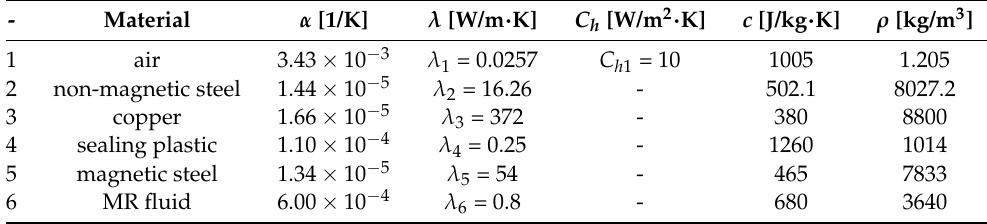
Table 3. Thermal coefficients for constructional materials and air (where α —thermal expansion coefficient; λ —thermal conductivity; C h —heat convection coefficient; c —heat capacity; ρ —mass